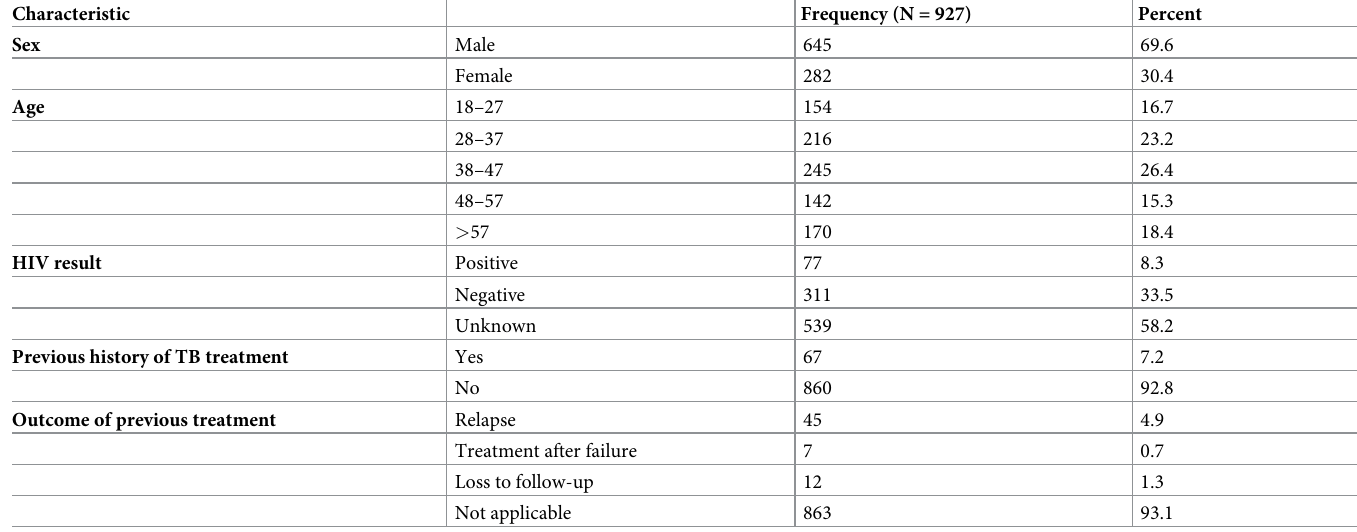
Table 1. Key demographic characteristics of patients enrolled in the National TB drug resistance survey in Ghana in 2017. Characteristic Frequency (N = 927) Percent Sex Male Age